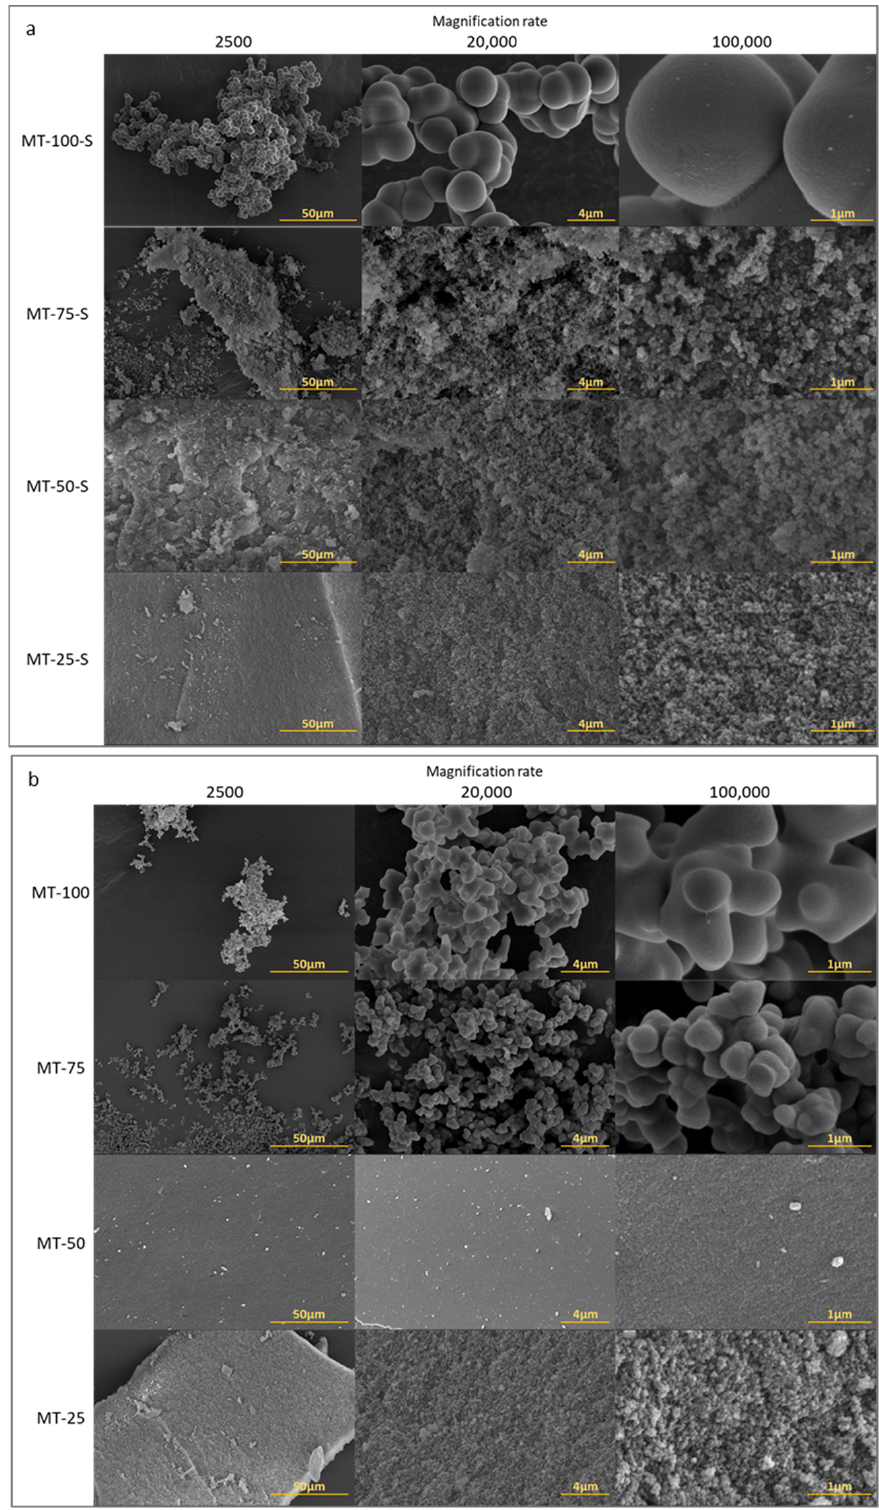
Figure 7. SEM micrographs of ( a ) silylated silica xerogels and ( b ) non ‐ silylated silica xerogels. At a high MTMS content (i.e., MT ‐ 75, MT ‐ 100, and MT ‐ 100 ‐ S), the particle agglomeration was more distinct; the particles were more regularly spherical in shape; and the network was looser with larger pores. In contrast, decreasing the amount of MTMS led to finer structures with a more compact morphology. Although the size and the cluster radii of the primary particles remained nearly the same with the addition of trifunctional organosilane to the xerogel network, the size of the secondary silica particles significantly varied with the methyl content because the reaction kinetics of classical tetraalkoxysilanes and trialkoxysilanes were not similar. The particles were primarily formed by the hydrolysis and condensation of tetraalkoxysilane (TEOS) and the